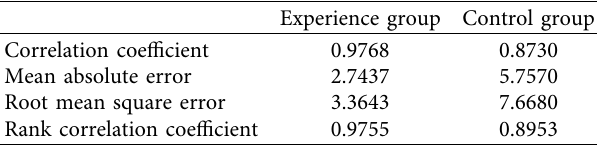
Figure 1: Image restoration effect. (a) Blurred image (b) Restoration rendering. Table 1: Comparison of edge correction performance of Gauss blur distortion